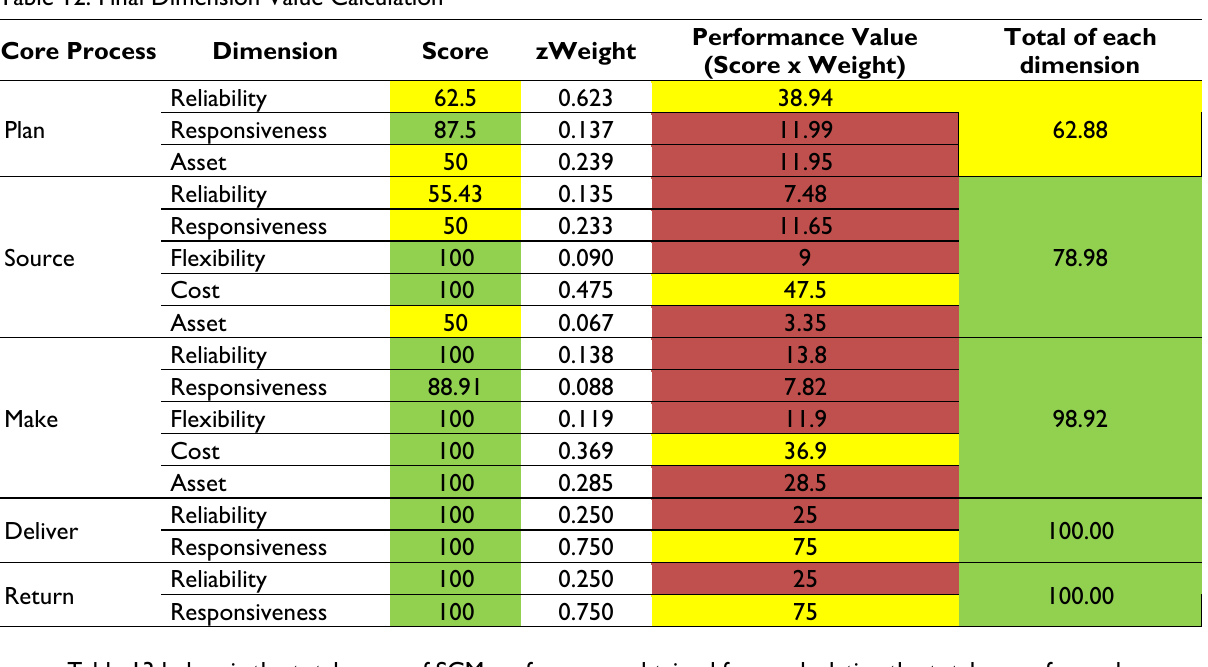
Table 13: Calculation of the Total Value of SCM Performance Core Process